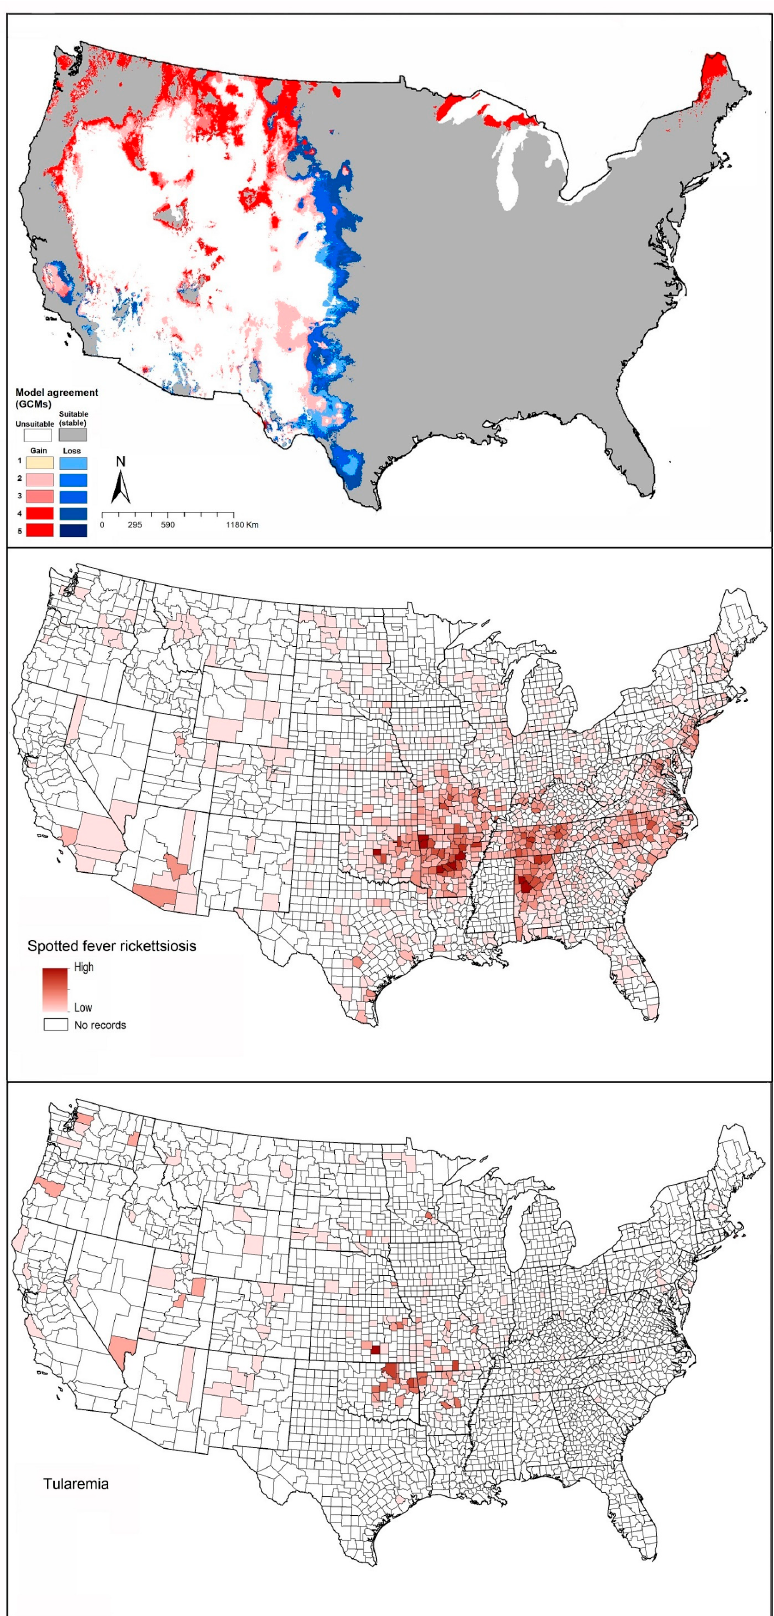
Figure 10. Geographic distribution of Dermacentor variabilis and the diseases that it likely transmits in the United States. Dark pink represents high incidence, light pink indicates low incidence. White represents no records.